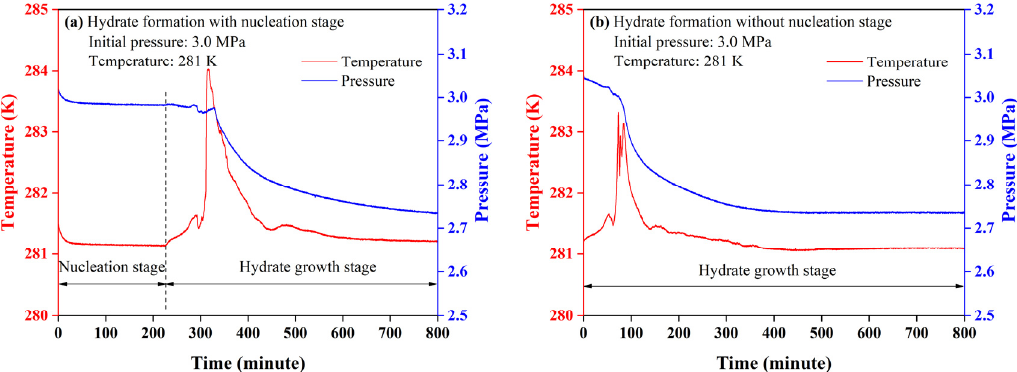
Figure 2. Temperature and pressure profiles of typical hydrate growth. ( a ) Hydrate formation with nucleation stage; ( b ) hydrate formation without nucleation stage.